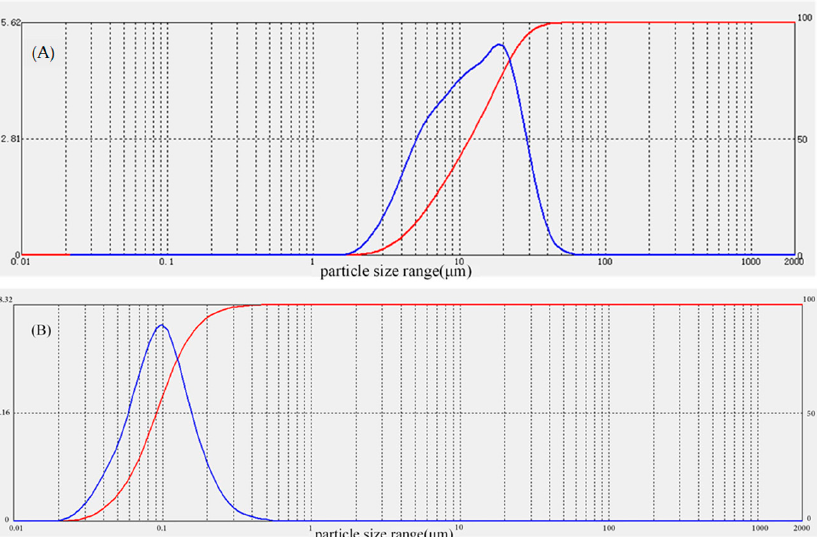
Figure 1. Particle size of the degraded soil ( A ) and water-jet loom sludge ( B ). The red line represents the differential, that is, the proportion of the individual particle sizes; the blue line is the cumulative curve representing the percentage of the previous grain size accumulation. The vertical axis represents the percentage content and the horizontal axis represents the particle size range. The particle size distribution pattern and law can be seen